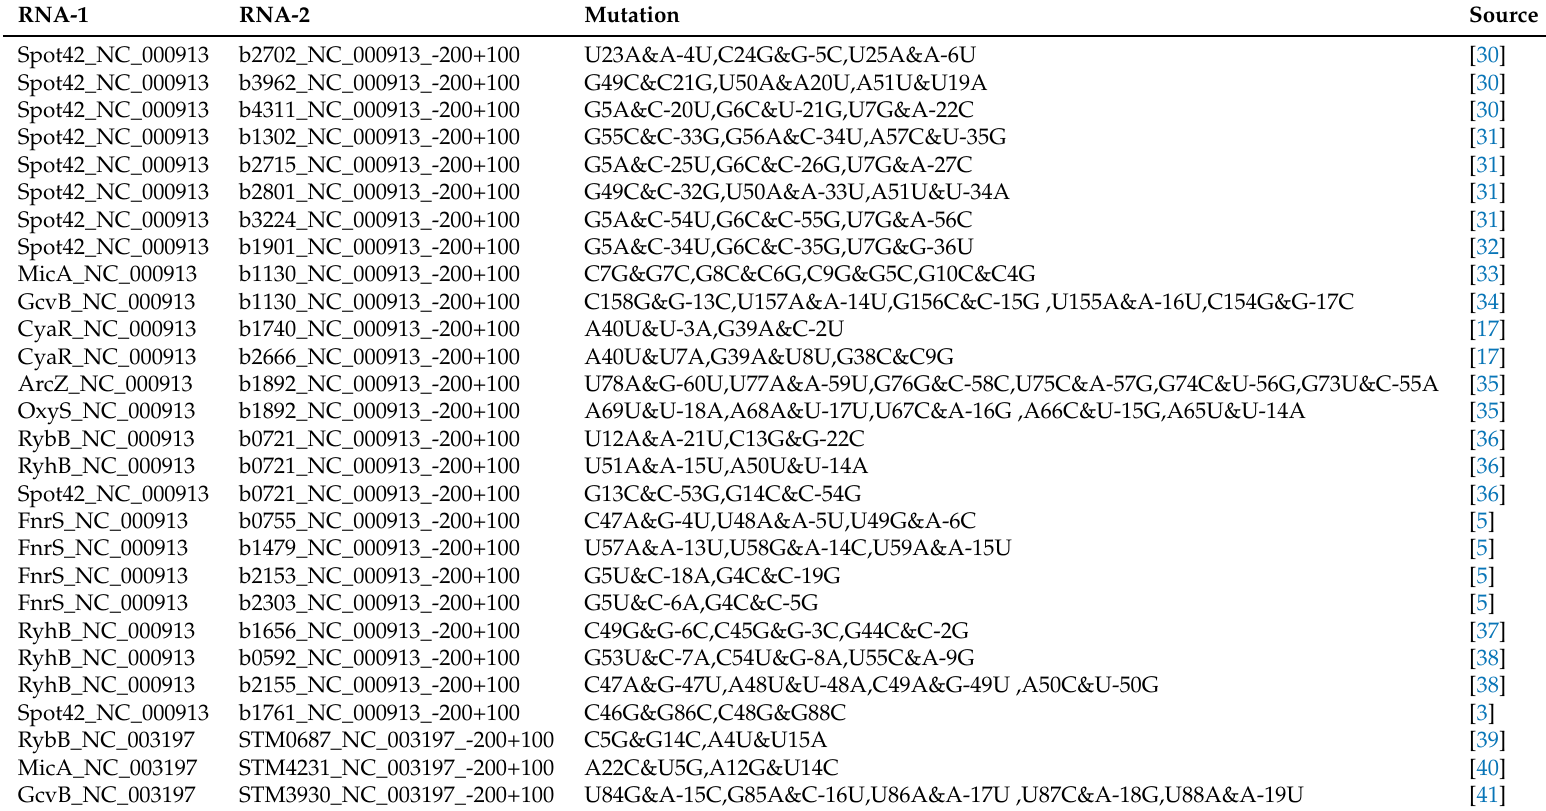
Table A2. Multi-nucleotide CoMs from literature used for this